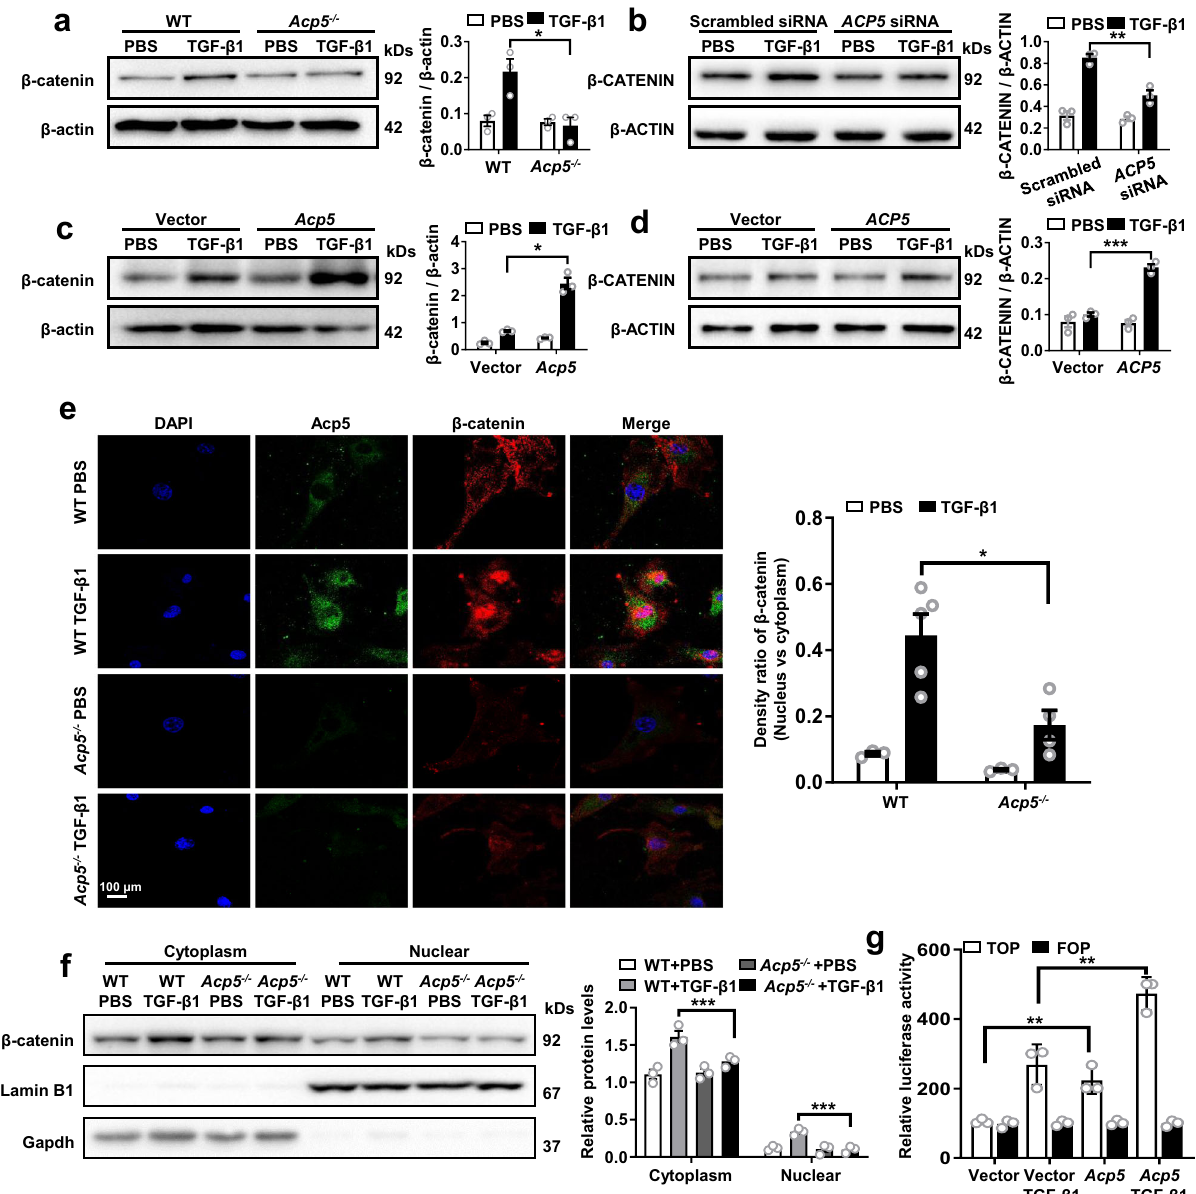
Fig. 4 Altered Acp5 expression affects the levels of β -catenin. a – d Western blot analysis of the levels of β -catenin in WT or Acp5 − / − PMLFs ( a , p = 0.0239), ACP5 siRNA or Scrambled siRNA treated PHLFs ( b , p = 0.0034), Acp5- plasmid or Vector treated Acp5 − / − PMLFs ( c , p = 0.0138) and ACP5- plasmid or Vector treated PHLFs ( d , p = 0.0003). e Representative results for coimmunostaining of Acp5 and β -catenin in PMLFs from WT and Acp5 − / − PMLFs following TGF- β 1 induction ( p = 0.0127). The nuclei were stained blue by DAPI, and the images were taken under original magni fi cation ×400. f Western blot analysis of the levels of β -catenin in cytoplasm ( p < 0.0001) and nuclear ( p = 0.0001). g Normalized luciferase activities of TOP- Flash over FOP-Flash relative renilla luciferase units (RLU) in PMLFs (Vector treated versus Acp5 -plasmid treated: p = 0.0064, Vector treated with TGF- β 1 versus Acp5 -plasmid treated with TGF- β 1: p = 0.0094). The data are represented as the mean ± SEM of three independent experiments. Two-sided Student ’ s t -test ( a – b, d – g ) and two-sided unpaired Student ’ s t -test with Welch ’ s correction ( c ) were applied. * p < 0.05; ** p < 0.01; *** p < 0.001. Source data are provided as a Source Data fi